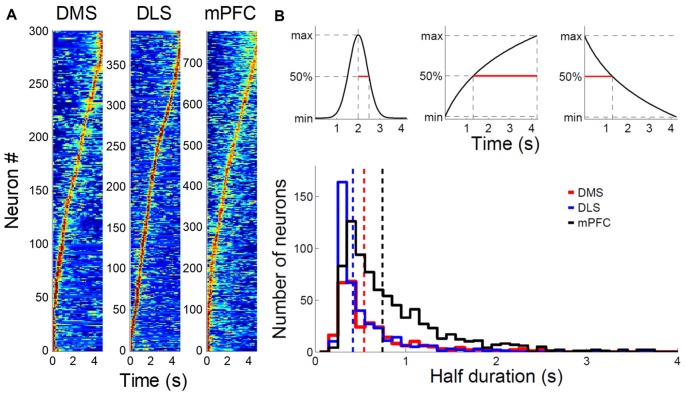
Comparison of striatal and medial prefrontal cortex (mPFC) neuronal activity profiles. (A) Normalized activity profiles of putative MSNs recorded from the DMS and DLS and putative pyramidal cells recorded from the mPFC (Kim et al., 2013) are shown for the longest sample interval (4,784 ms). Units were aligned according to the time of peak firing (red). Dark blue indicates no firing. (B) Top, activity half-duration was defined as the duration between the maximal and half-maximal activity for each neuron. Bottom, activity half-duration was estimated for putative MSNs of the DMS (red) and DLS (blue) as well as putative pyramidal cells of the mPFC (black) for the longest sample interval. Dashed lines denote mean half-durations in corresponding colors. Only correct trials were included in the analysis.